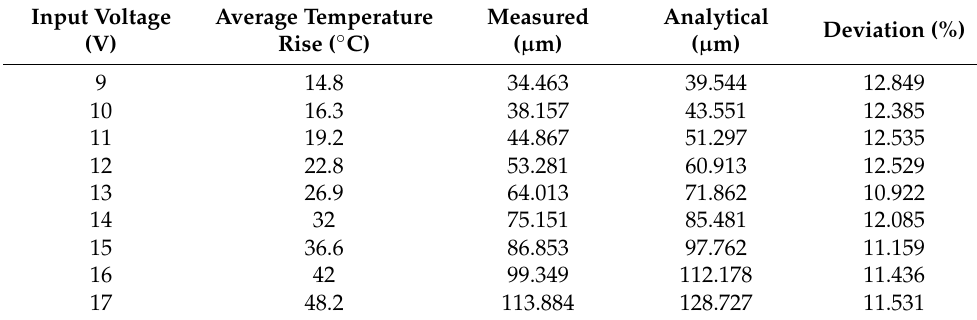
Table 4. Comparison of output displacement between analytical and experimental results.